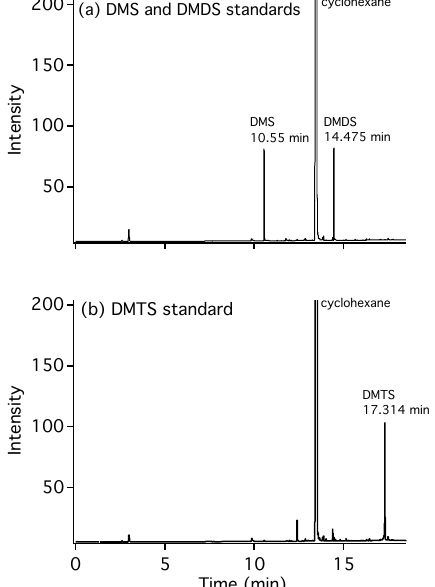
Figure 2. GC-FID chromatogram for (a) DMS ( ∼ 21ppb) and DMDS ( ∼ 20ppb) and (b) DMTS ( ∼ 22ppb) standards from the dynamic injection system. The cyclohexane peak is due to the sol- vent used in the injection system. Analysis followed immediately after canister samples were